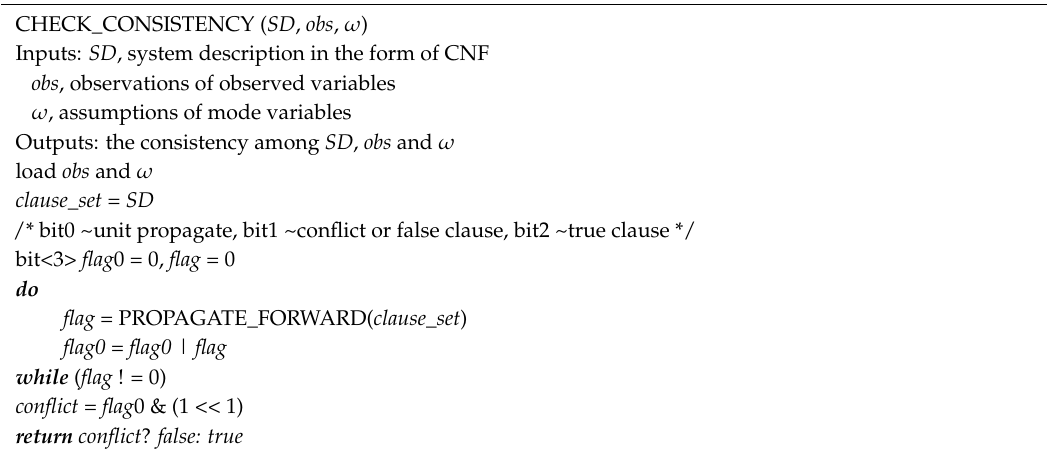
Algorithm 1. Pseudocode of CHECK_CONSISTENCY for Multi-Conflict and Multi-Consistency-LTMS (MCMC-LTMS).